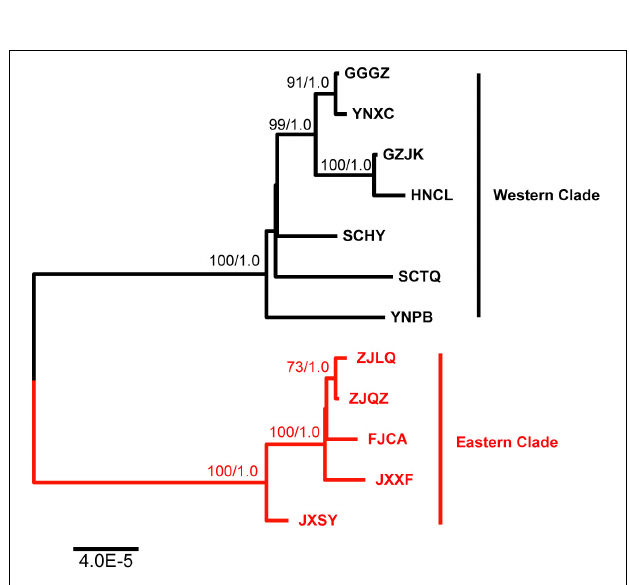
FIGURE 7 | Numbers and patterns of indels among the B. sinensis chloroplast genomes. (A) Numbers and sizes of indels. (B) Numbers of indels in the LSC, SSC, and IR regions. (C) Numbers of SSRs in spacers, exons, and introns.